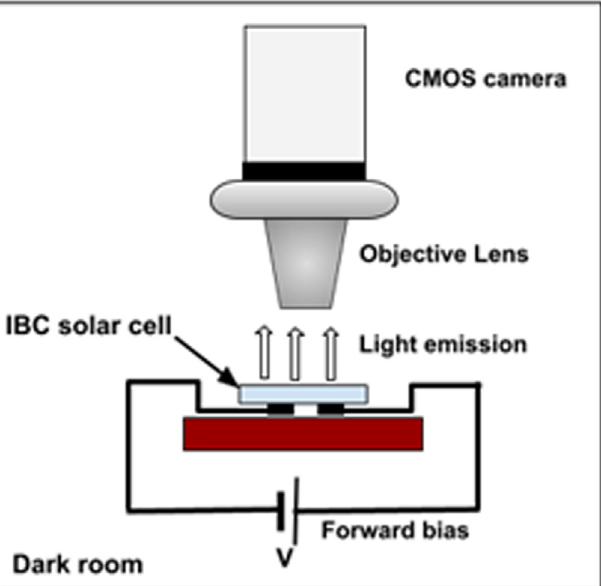
Fig 1. Schematic of EL setup.